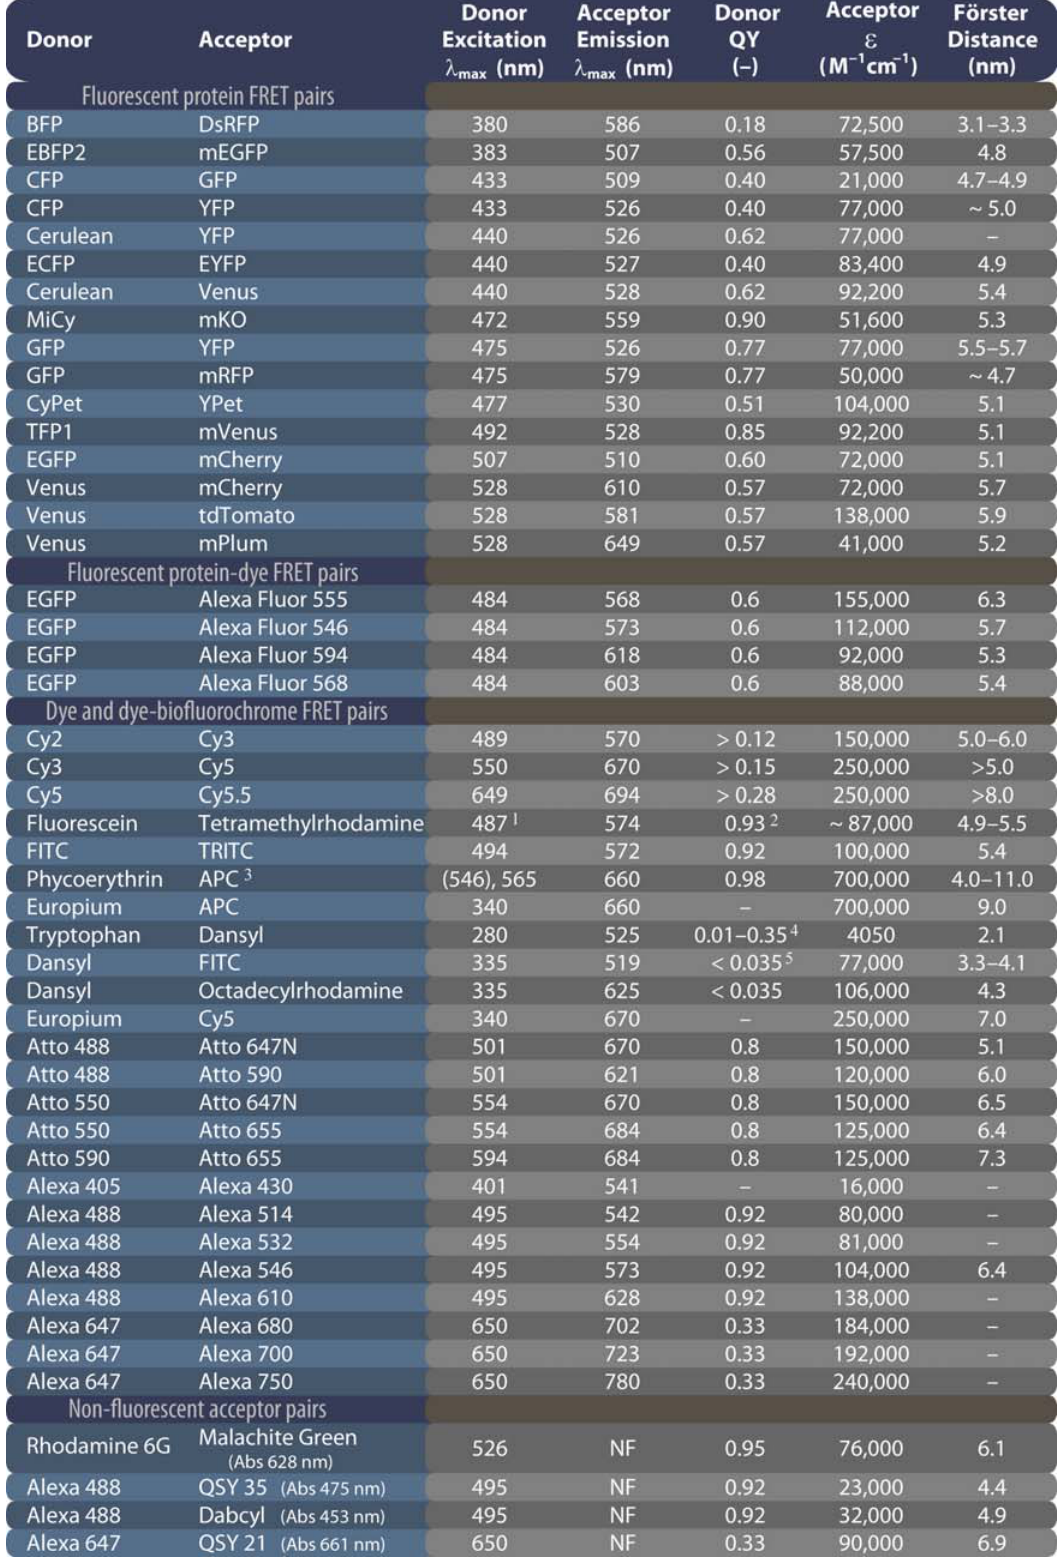
Table 2. Overview popular organic dye and fluorescent proteins FRET couples and some relevant photophysical